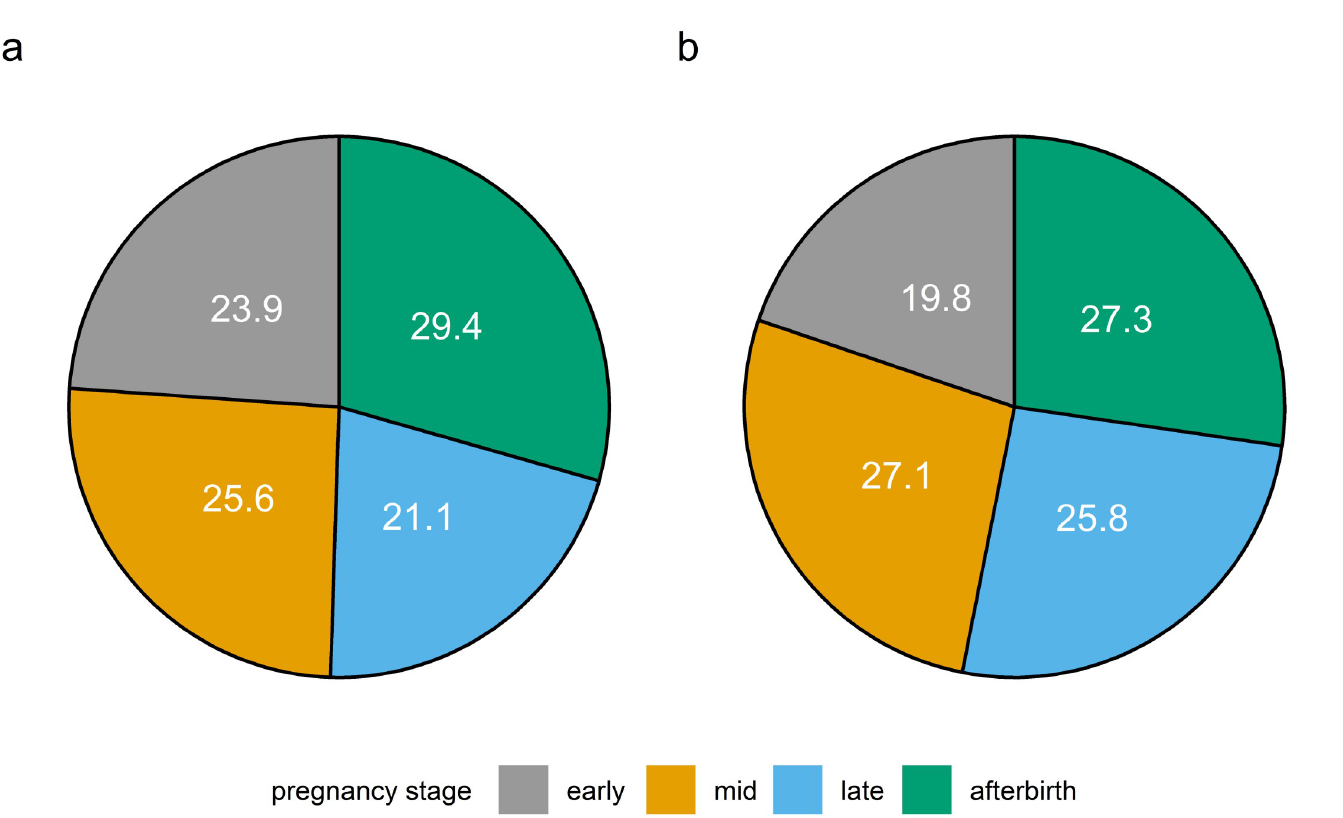
Fig 4. Relative proportions among the different pregnancy states for (a) glycosylated samples and (b) deglycosylated samples. Note the different basic population of Total Area Fragment (a = 4,774,159; b = 7,567,626).